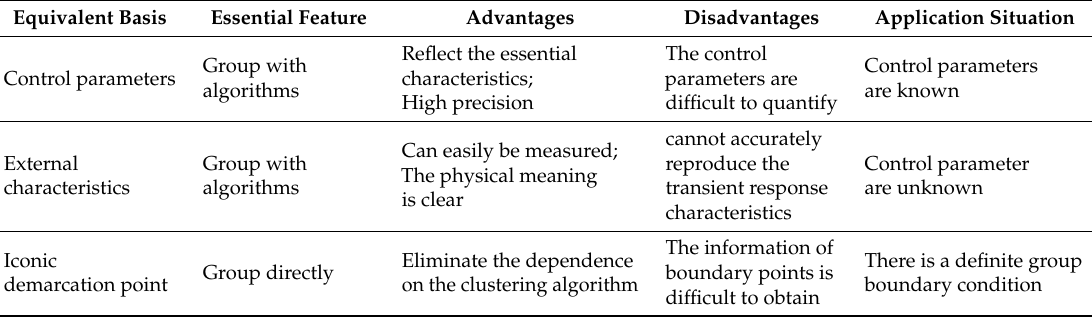
Table 3. The multi-machine equivalent method of PV power plants.